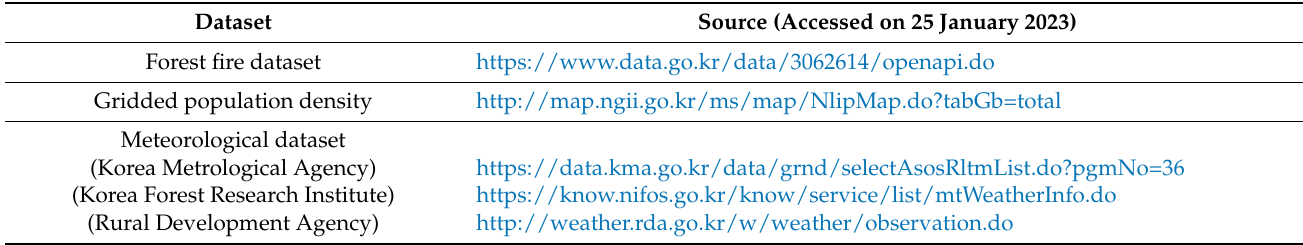
Table A1. Source of